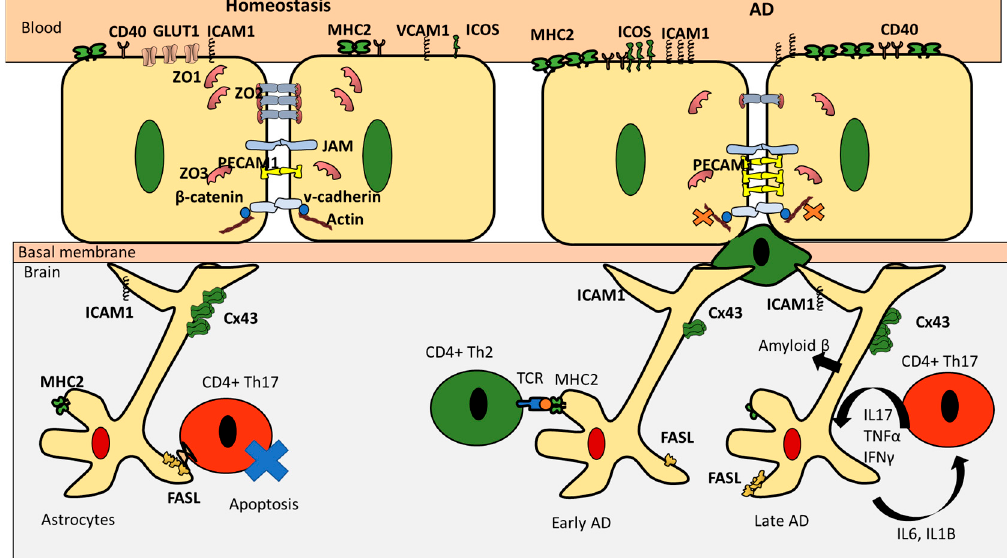
Figure 3. A comparison between CD4+ T cells interaction with the BBB in health and disease. During homeostasis, ICAM1 and VCAM1 are downregulated to deter adhesion. Occludin, ZO1, ZO2, and ZO3 are upregulated to main integrity. Cadherin is upregulated and PECAM1 is downregulated to prevent infiltration. This picture is mirrored in case of pathology, where the BBB loses its integrity, becomes more permeable, and increases the possibility of lymphocytes adhesion through upregulating VAM1 and ICAM1. During homeostasis, astrocytes upregulate Cx43 and FASL to inhibit CD4+ T cells infiltration. During the earlier stages of the disease, they downregulate Cx43 and present amyloid to Th2. However, during late phases of the disease, astrocytes themselves become a source of amyloid β and produce IL-6 and IL-1B which help recruit more pathogenic Th17 that produce proinflammatory cytokines forming a cycle of activation of pathological pathways.